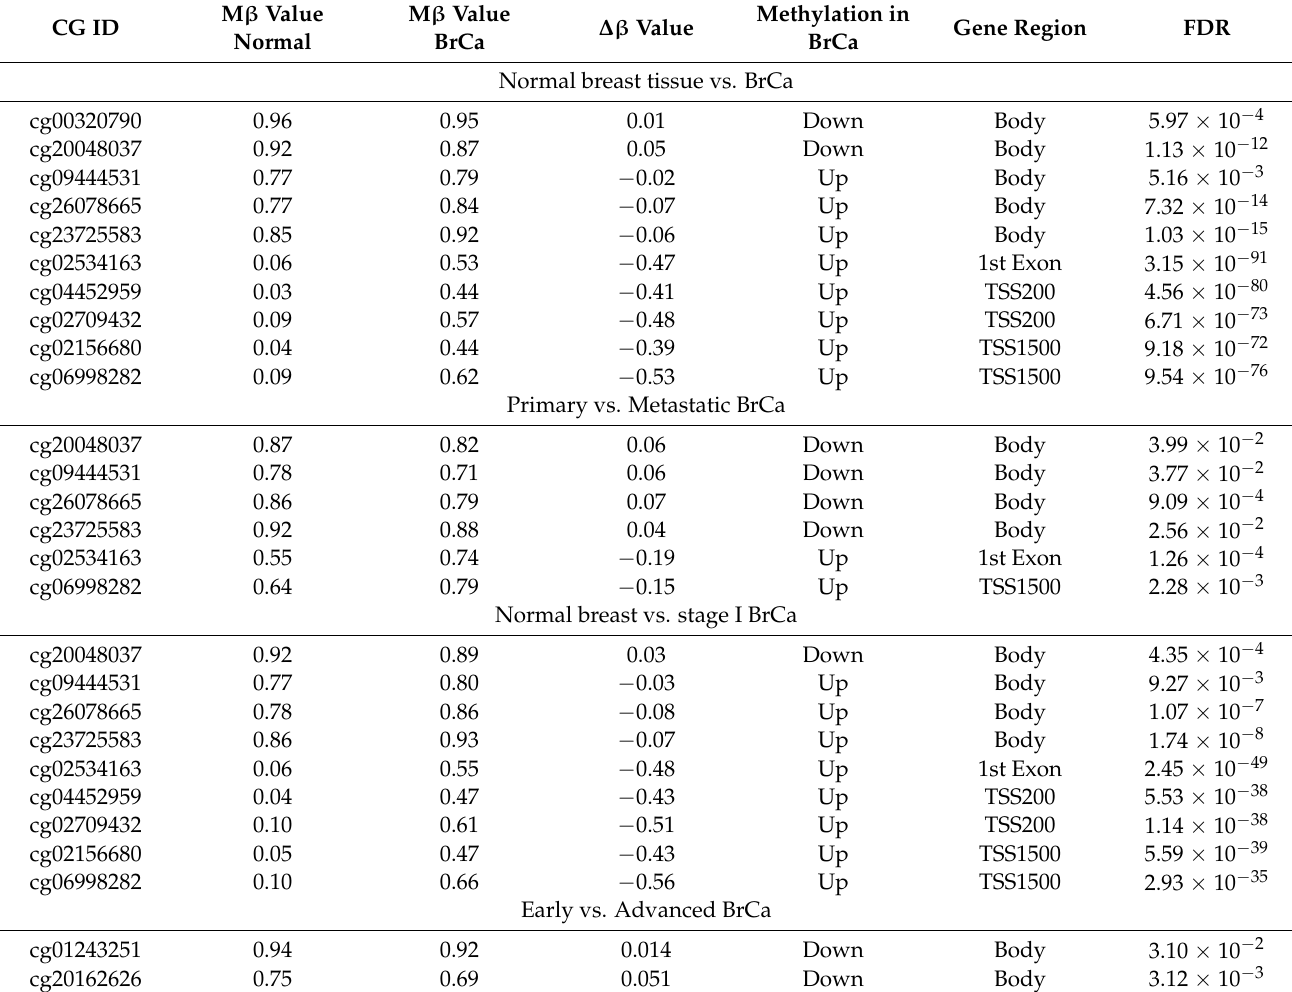
Table 1. ENPP2 DMCs identified via in silico analysis of BrCa and normal breast tissues.